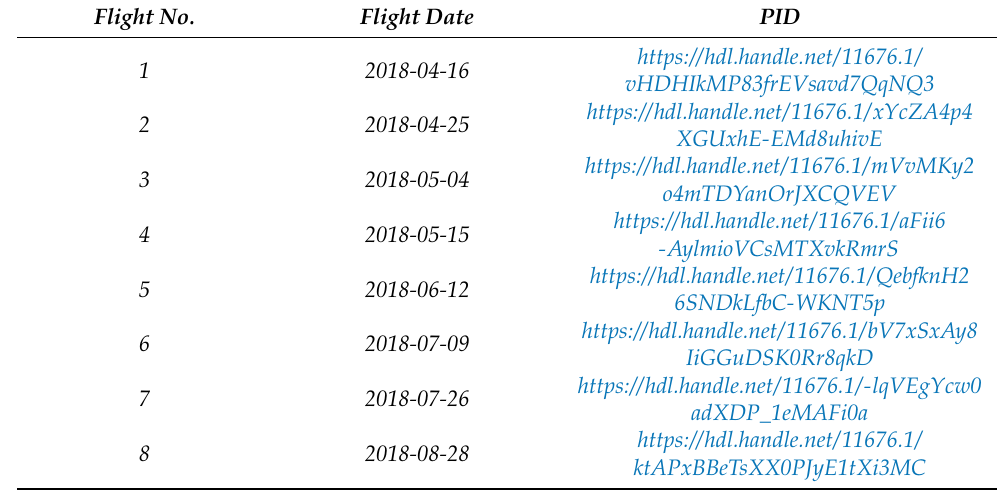
Table A1. Information on the UAV flights conducted during 2018 and their corresponding PIDs. Flight